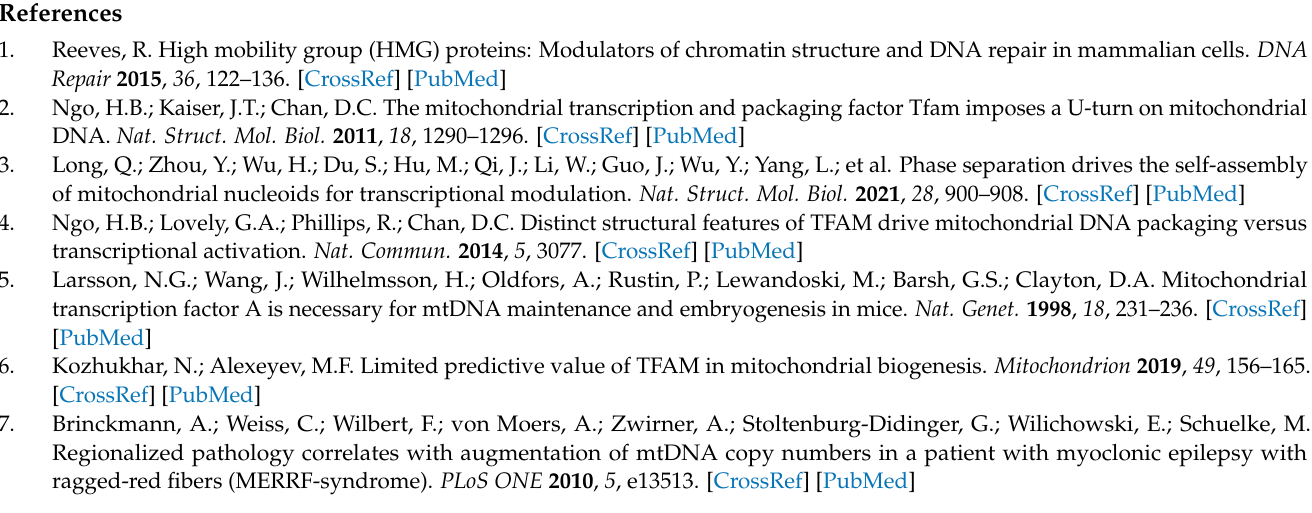
Figure S2: Amino acid residues in contact with DNA in hTFAM and corresponding residues in chT- FAM; Table S1: Nucleotide sequences of TFAM variants used in this study; Table S2: Oligonucleotides used in this